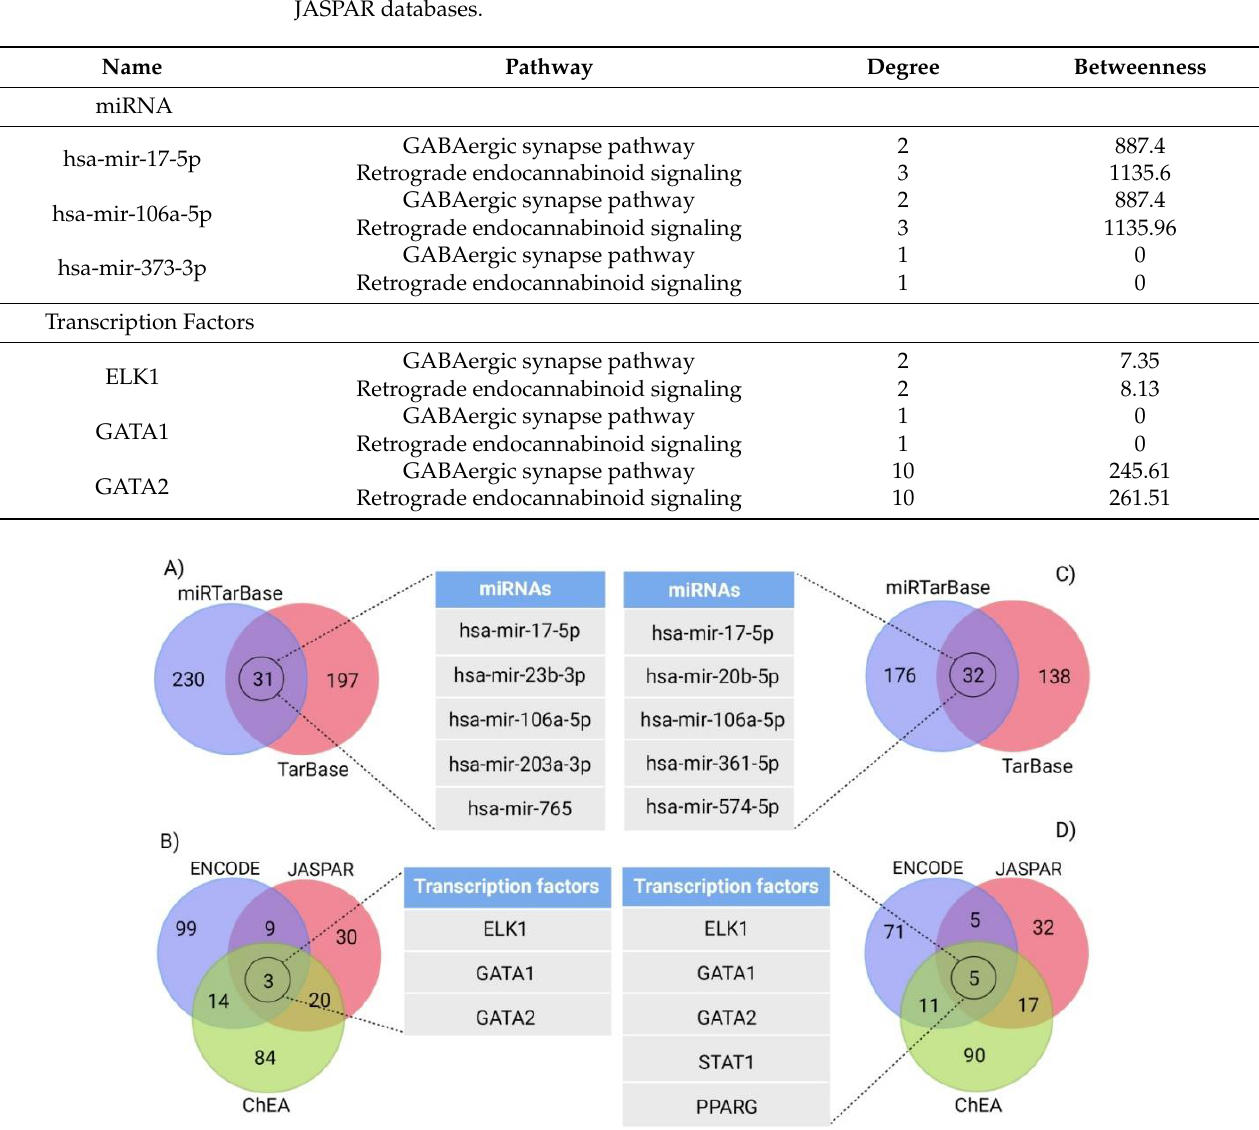
Figure 4. Transcription factors and miRNAs analyses. ( A ) and ( B ) results represent Venn diagram analysis for the top five miRNAs and the three TFs that interact with the robust DEGs of the GABAergic synapse pathway. ( C ) and ( D ) show Venn diagram analysis and the top five miRNAs and the TFs interacting with the robust DEGs involved in retrograde endocannabinoid signaling.